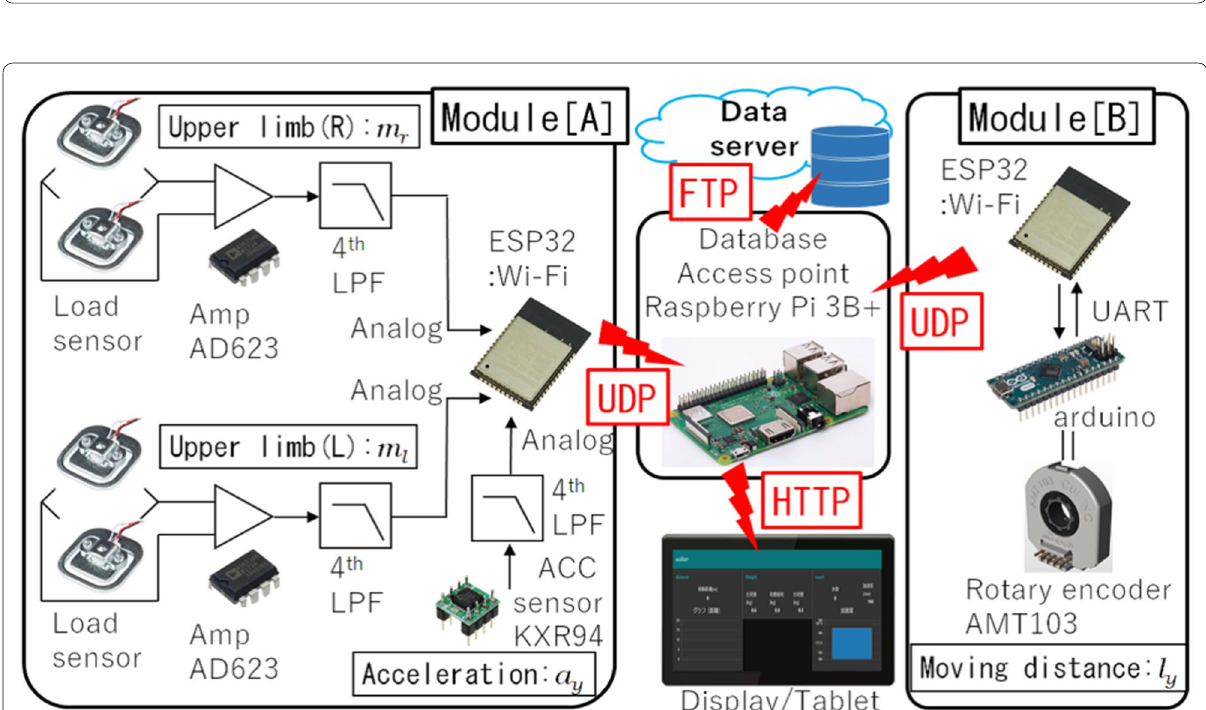
Fig. 4 Measurement system based on the IMSM that was implemented on the rolling stand-up walker—each sensor system was modularized to allow access using the server in the Layer 3 using UDP over Wi-Fi, user rehabilitation CSV data files were transferred in the Layer 5 to the server using FTP